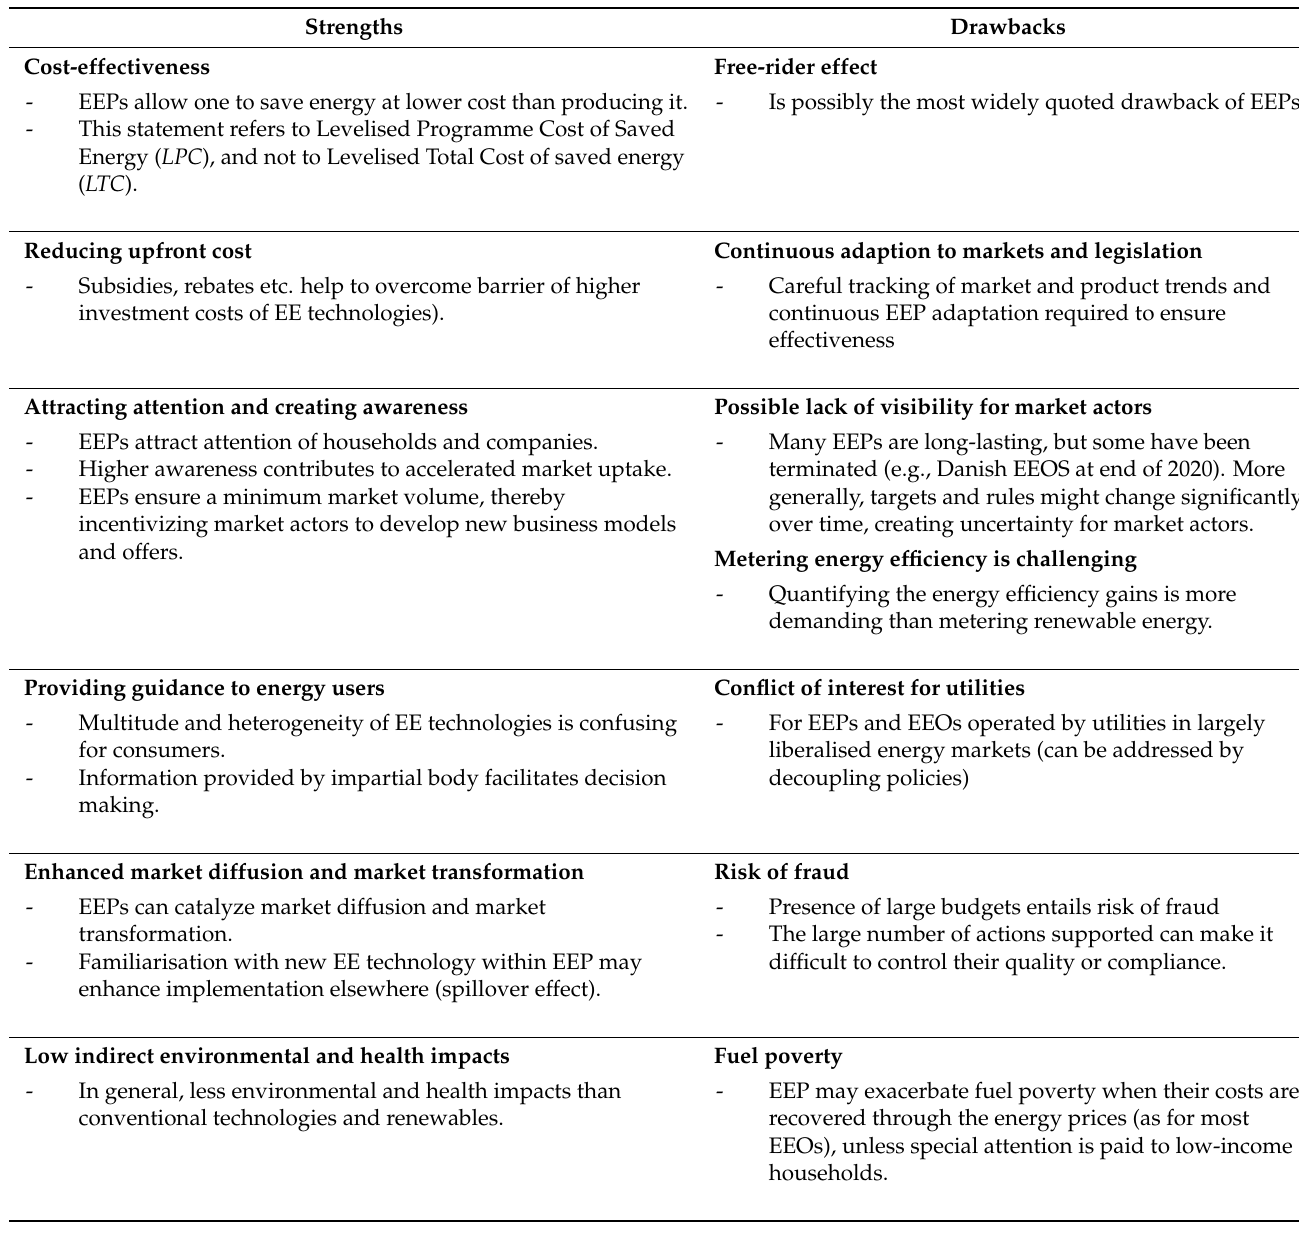
Table 3. Overview of the strengths and drawbacks of